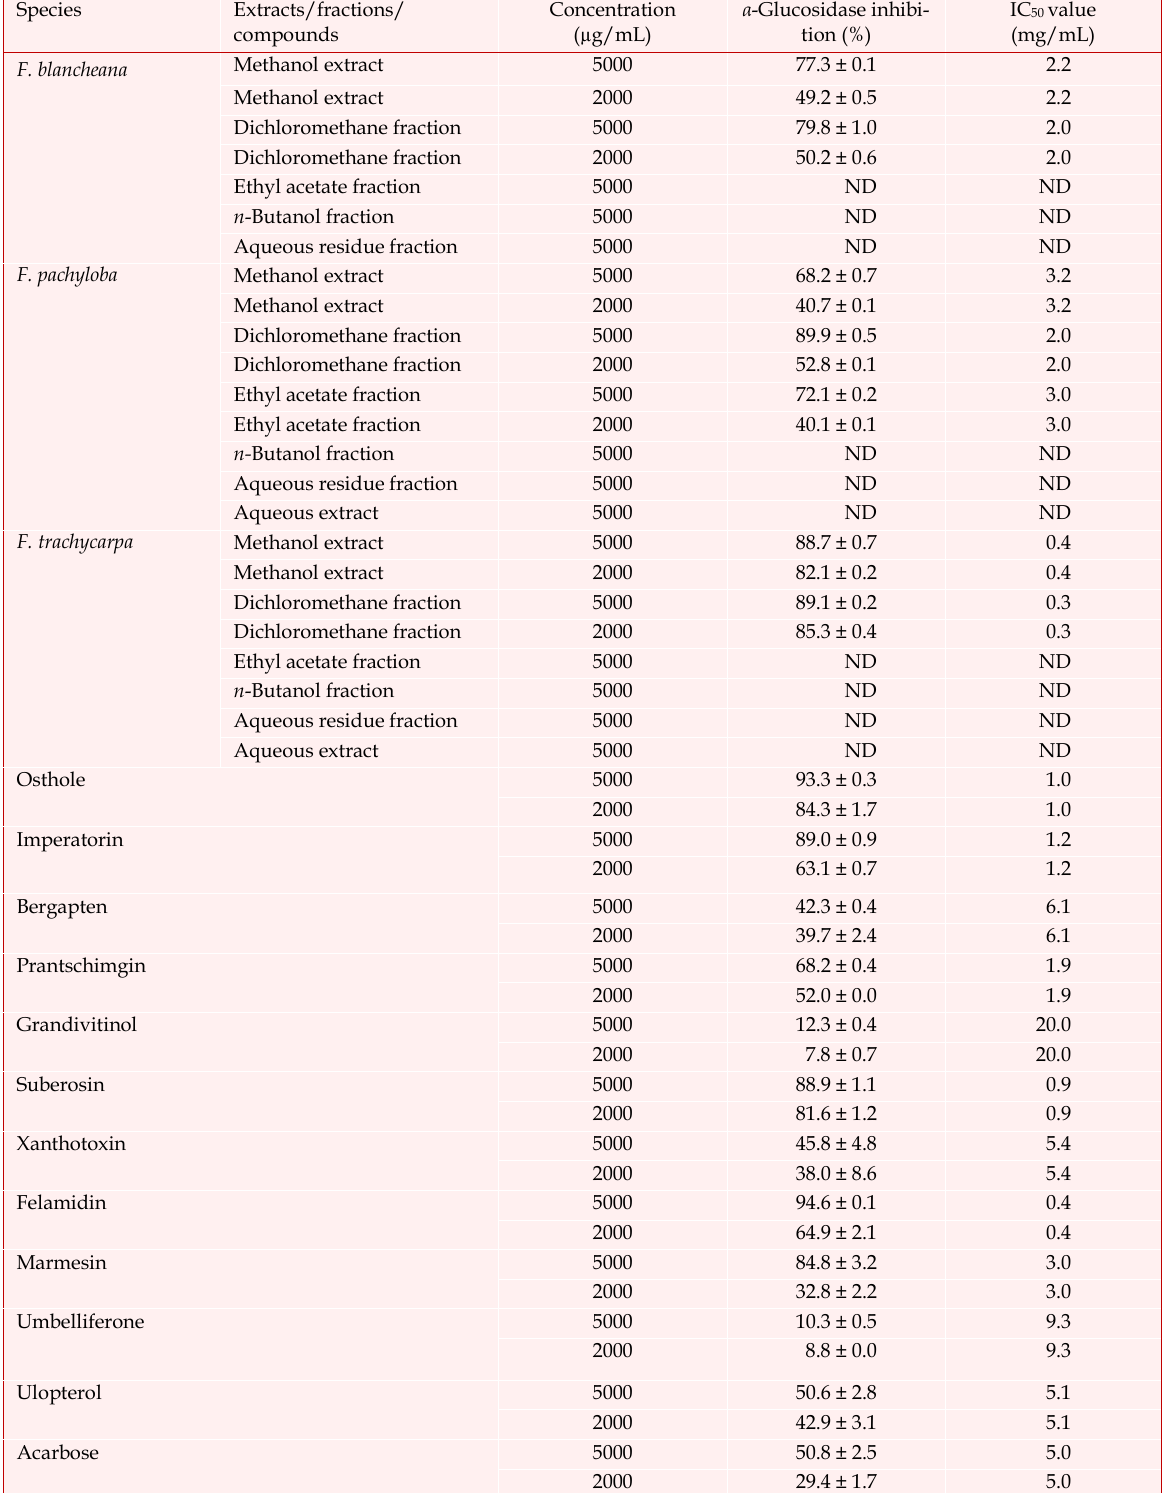
oba and F. trachycarpa